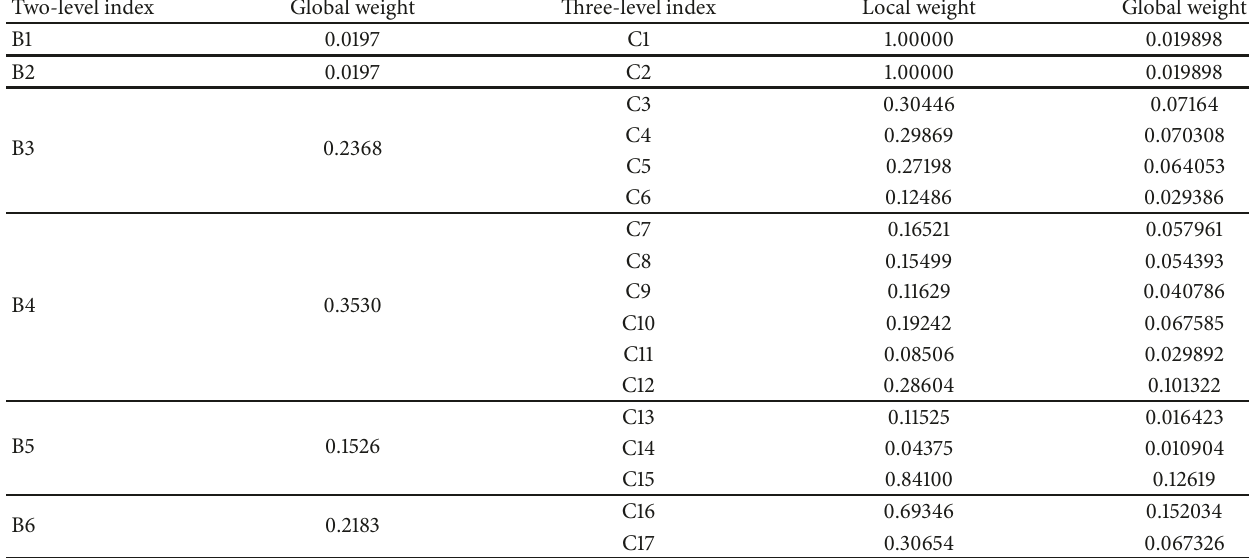
Table 2: Local weights and global weights of each